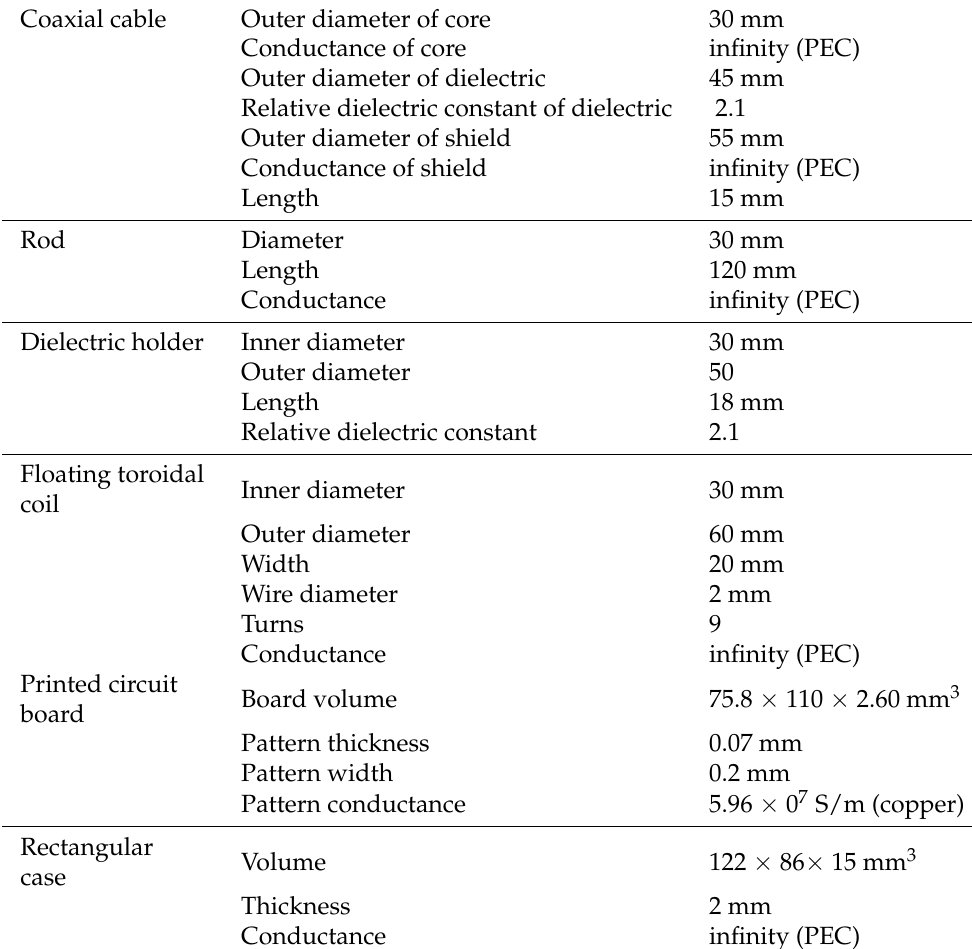
Table 2. Dimensions used in the optimization simulation. PEC: perfect electric